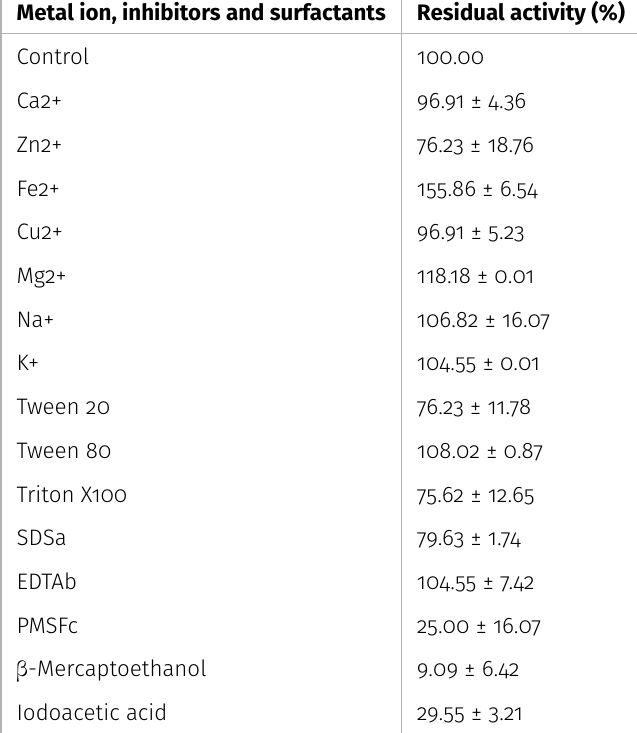
to it was obtained by Nascimento et al. 2017 (125 mm 2 ) from Mucor subtilissimus UCP 1262 and less than obtained by de Souza et al. 2016 (660.52 mm 2 ) from Bacillus amyloliquefaciens